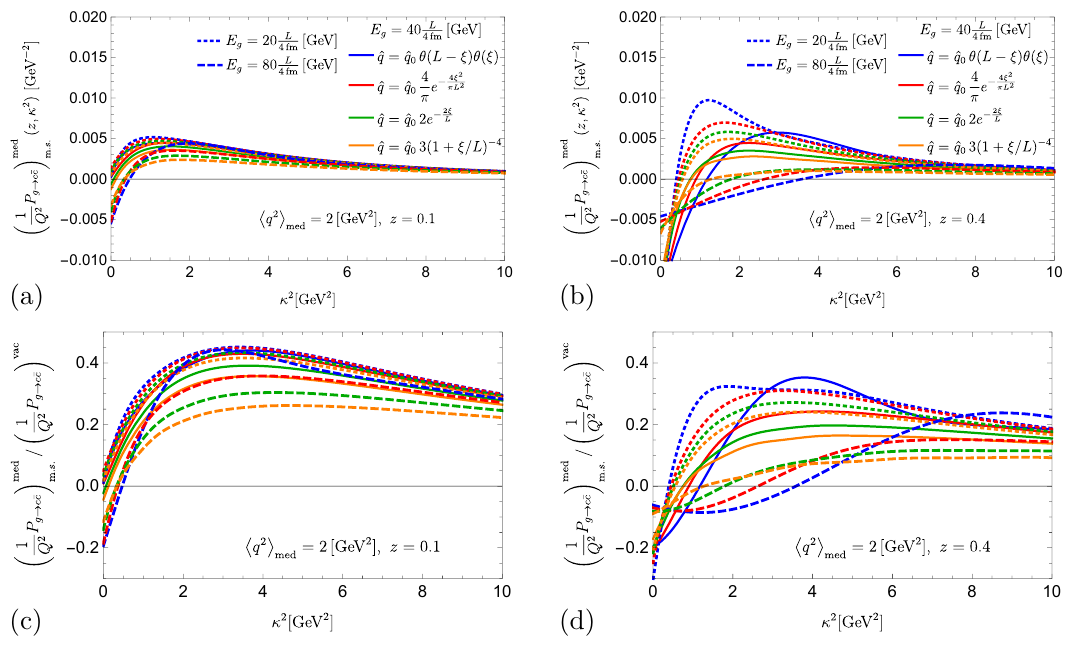
Figure 9 . Medium-modified splitting functions for three different expanding media (red, green and orange curves) compared to an equivalent static medium (blue curves). Results for three different gluon energies are compared for (a) z = 0 . 1 and (b) z = 0 . 4 as a function of (cid:20) 2 . Panels (c) and (d) show the results of (a) and (b) divided by the vacuum splitting